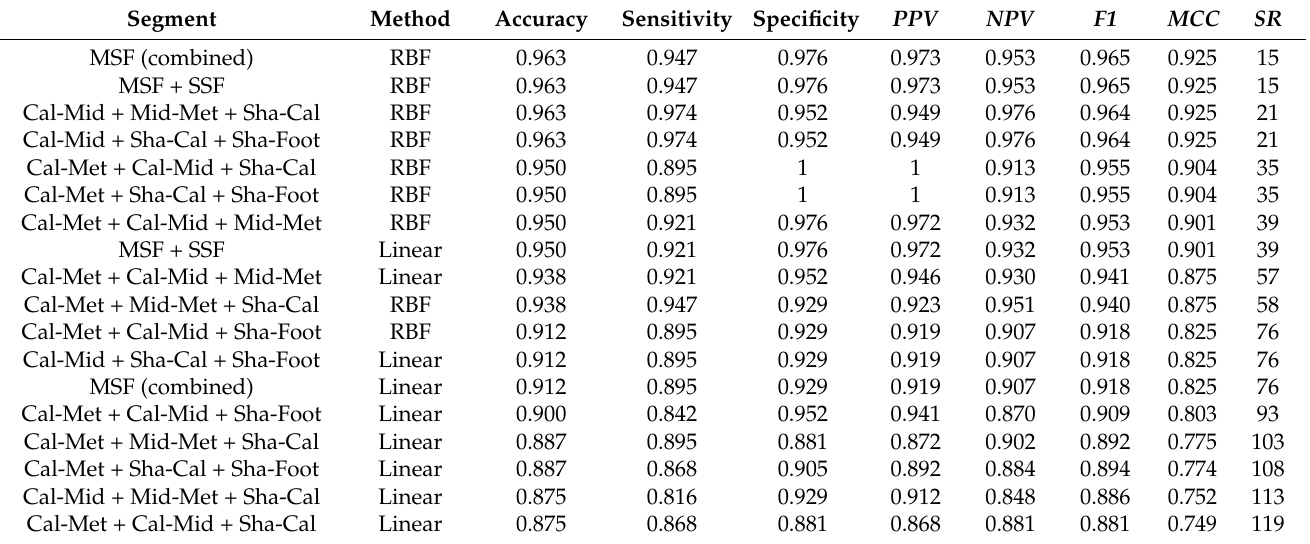
Table 3. Classification models based on level-3, 4 and 5 combinations of SSF and MSF features.